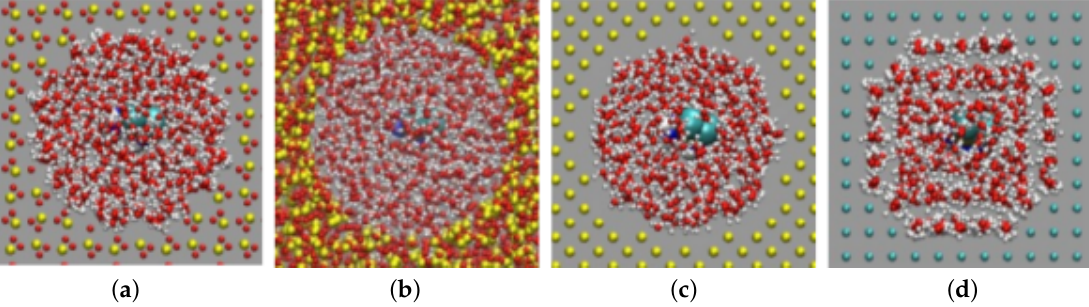
Figure 1. Cross-sectional view of the nanopore at the end of the equilibration stage showing the water hydration shells surrounding the pore walls. ( a ) Axial cristobalite pore; ( b ) amorphous silica; ( c ) silicon; ( d ) gold. Oxygen is colored red and hydrogen